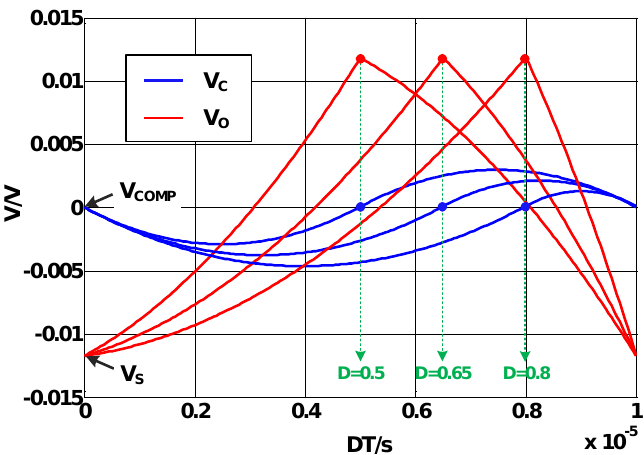
V using Laplacian O